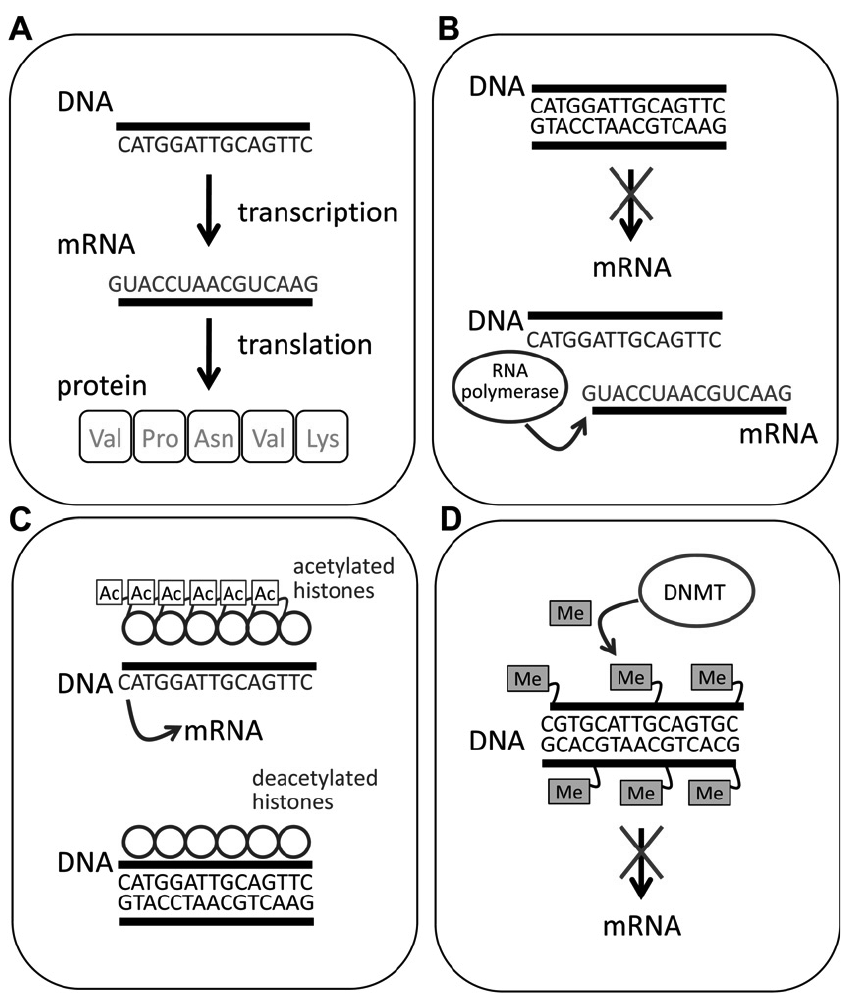
Figura 2. Regulação do gene e mecanismos epigenéticos (Gudsnuk & Champagne, 2011, p.